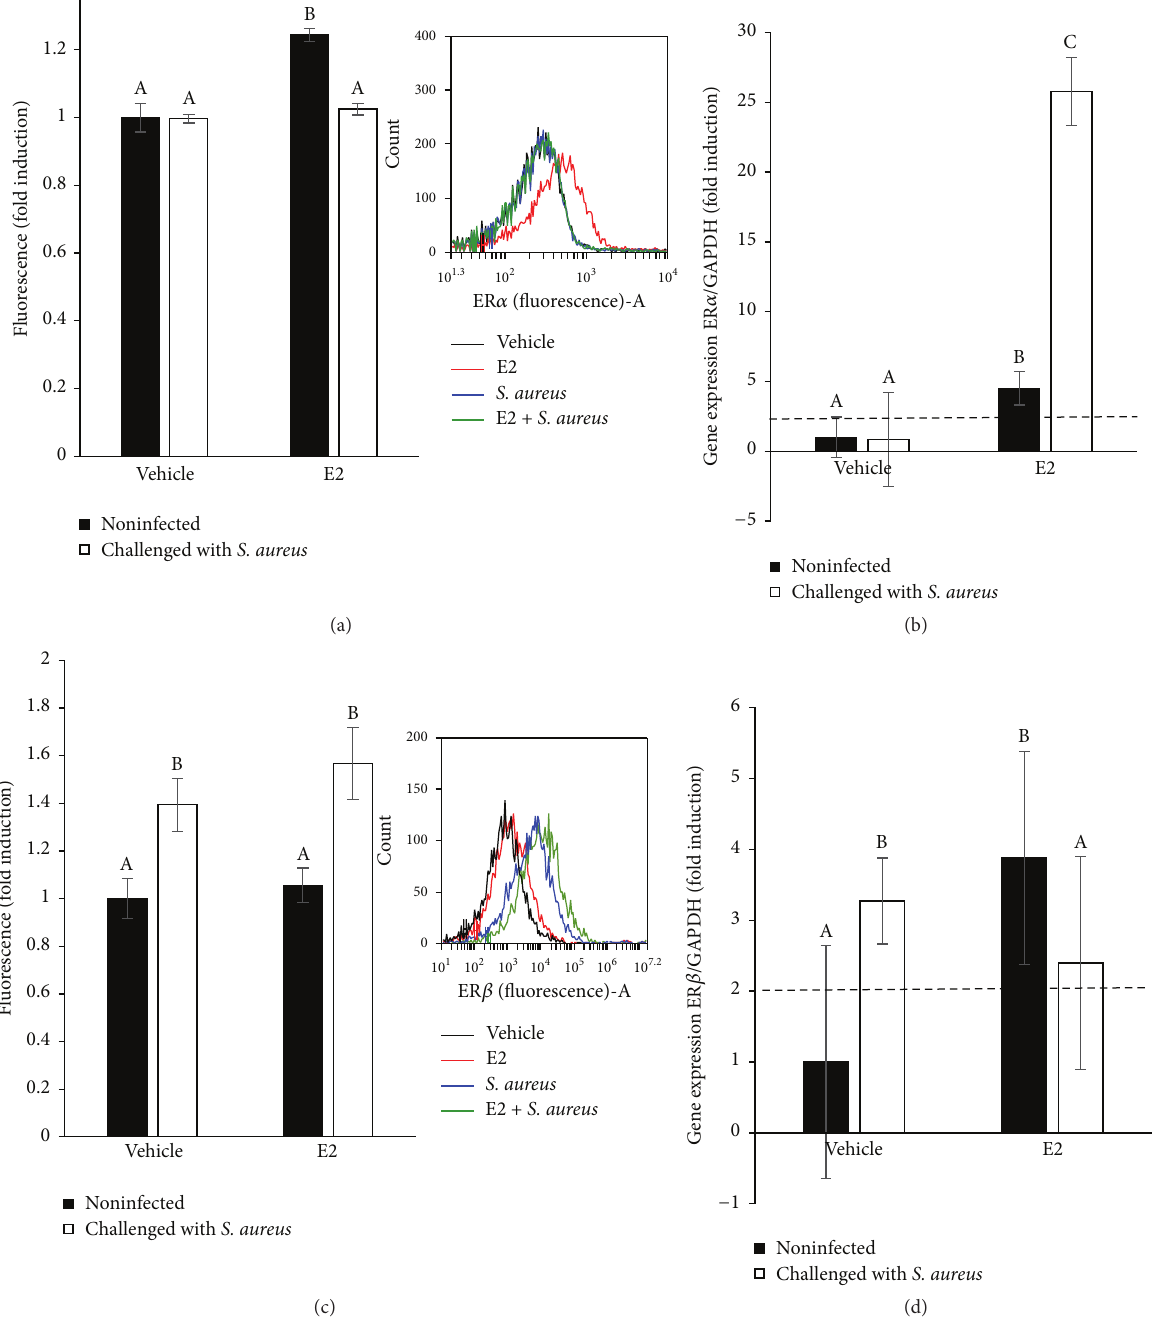
Figure 6: Participation of ERs in E2-treated bMECs. (a) The relative fluorescence intensities of ER 𝛼 activation in bMECs treated with E2 and infected with S. aureus are shown. Fluorescence intensity was estimated from 10,000 events. An inserted histogram plot that shows ER 𝛼 staining data in vehicle-treated bMECs (black line), cells that were challenged with S. aureus (blue line), cells that were stimulated with E2 (red line), and E2-treated bMECs infected with S. aureus (green line). The bMEC nuclei were fixed and stained with an anti-pER 𝛼 antibody overnight and analyzed with flow cytometry. (b) The ER 𝛼 mRNA expression was analyzed by RT-qPCR and GAPDH was used as endogenous gene in all conditions. Fold-change values greater than 2 or less than 0.5 were considered as significant differentially expressed mRNAs. Each bar shows the mean of triplicates ± SD of three independent experiments. (c) The relative fluorescence intensities of ER 𝛽 activation in bMECs treated with E2 and infected with S. aureus are shown. Fluorescence intensity was estimated from 10,000 events. An inserted histogram plot that shows ER 𝛽 staining data in vehicle-treated bMECs (black line), cells that were challenged with S. aureus (blue line), cells that were stimulated with E2 (red line), and E2-treated bMECs infected with S. aureus (green line). The bMEC nuclei were fixed and stained with an anti-ER 𝛽 antibody overnight and analyzed with flow cytometry. (d) The ER 𝛽 mRNA expression was analyzed by RT-qPCR and GAPDH was used as endogenous gene in all conditions. Fold-change values greater than 2 or less than 0.5 were considered as significant differentially expressedmRNAs.Eachbarshowsthemeanoftriplicates ± SDofthreeindependentexperiments.Differentlettersindicatesignificantchanges among treatments ( 𝑃 < 0.05 ). Vehicle: 1%